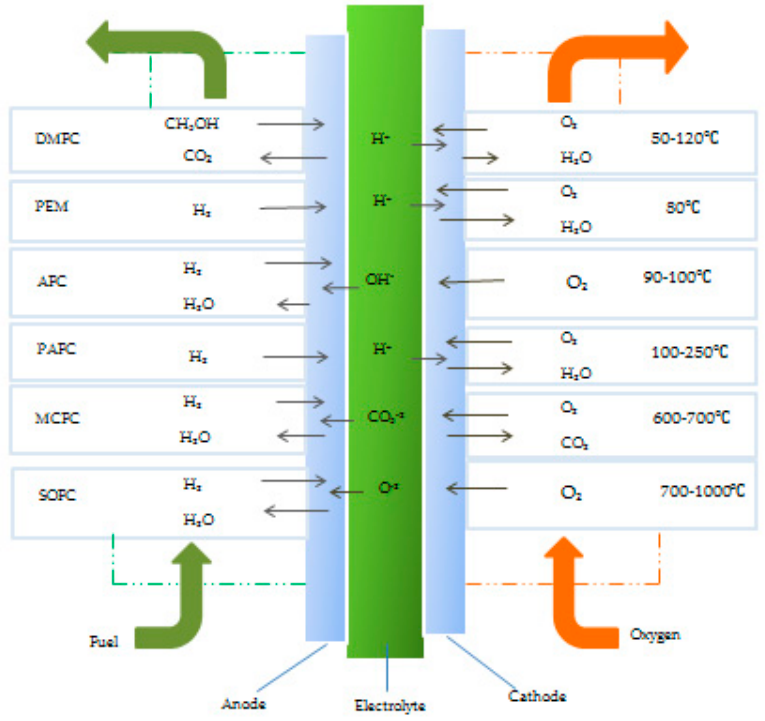
Figure 2. Schematic diagram of electrode reactions and products and operating temperatures of different types of fuel cells.